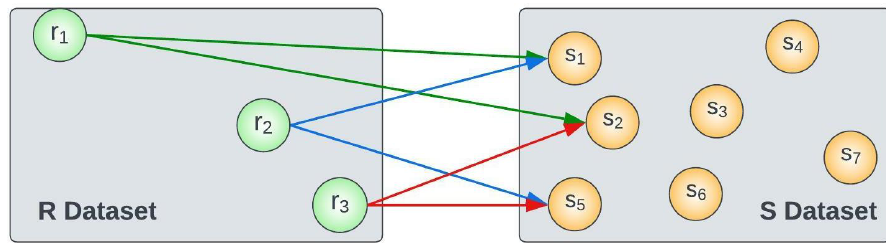
Figure 2. An example of kNN Join with k =